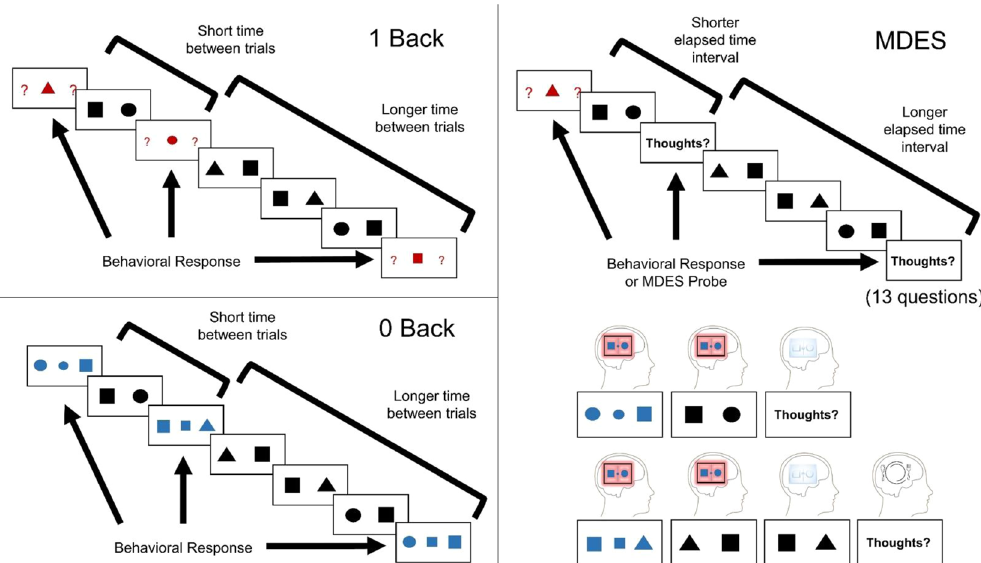
Figure 5. The task consisted of two conditions. In both conditions, participants had to make a spatial decision on the location of a shape shown in the middle of the target trial. In the 0-back, they had to say which side of the screen the shape was on during that trial (perceptually-guided decision). In the 1-back, they had to say which side of the screen the shape had been on the previous trial (memory-guided decision). On a quasi-random basis, the target trials were replaced by thought probes that asked 13 questions about the participants’ thoughts. These always started with a question about task focus, then the other 12 question (see Supplementary Table 2) were in a random